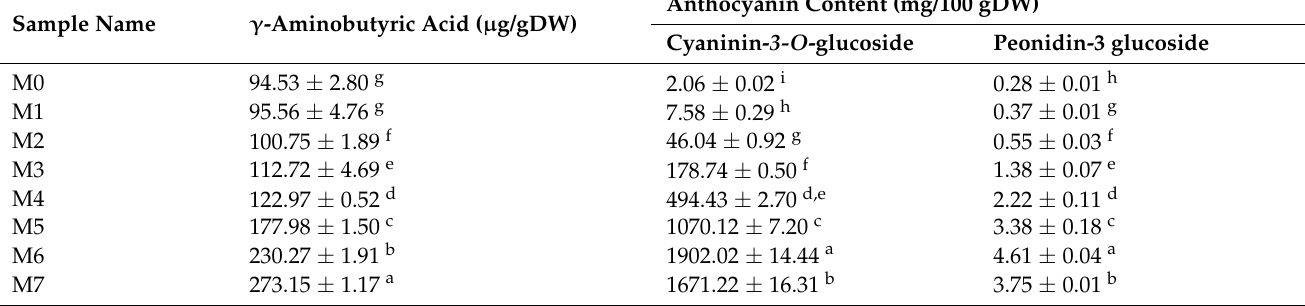
Table 5. Changes in γ -aminobutyric acid and anthocyanin content of mulberry fruit during ripen- ing